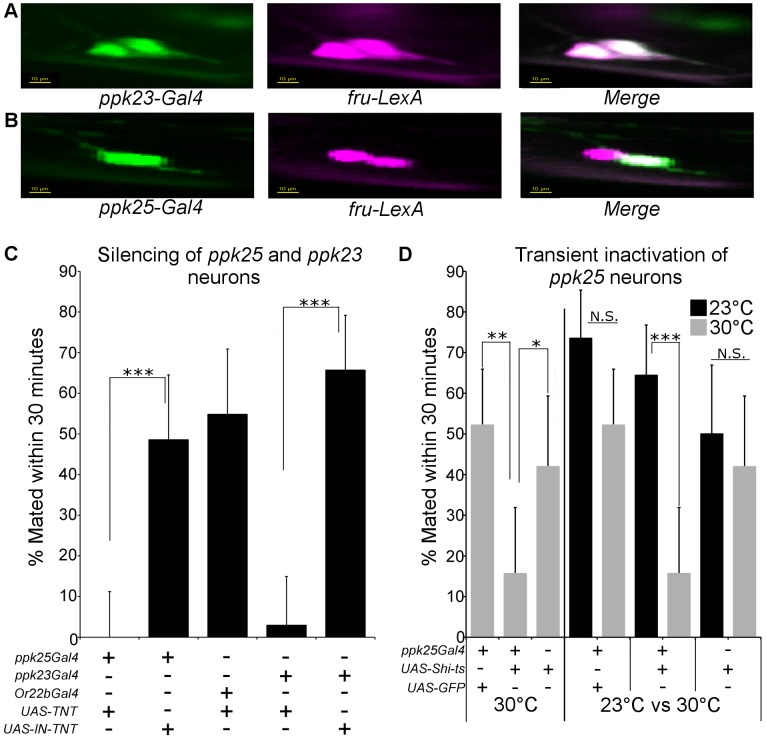
Female ppk25-Gal4 neurons represent a subset of ppk23-Gal4 neurons and are involved in female receptivity.A. Segment of female front legs showing expression of ppk23-Gal4 (green) in each of the two fru-positive cells (fru-LexA, magenta) under each chemosensory bristle. Scale 10 µm. B. Segment of female front legs showing expression of ppk25-Gal4 (green) in only one of the two fru-positive cells (fru-LexA, magenta) present under each chemosensory bristle. Scale 10 µm. C. Silencing of ppk25-Gal4 or ppk23-Gal4 neurons reduces female receptivity. Receptivity was calculated for females expressing active (UAS-TNT) or inactive (UAS-IN-TNT) forms of TNT under control of either ppk23-Gal4 or ppk25-Gal4. Additional control females contained UAS-TNT driven by Or22b-Gal4, which is expressed in a neuronal subset not associated with mating behaviors [36]. N = 30–35; ***p<0.001 (Fisher's exact test). D. Transient inactivation of ppk25-Gal4 neurons inhibits female receptivity. Females expressing the temperature-sensitive dominant Dynamin allele shits
[37] under control of ppk25-Gal4 were incubated at either permissive (23°C) or non-permissive (30°C) temperature for 20 minutes prior to, and during the test. Receptivity for females expressing GFP in ppk25-Gal4 neurons or females with UAS-Shi(ts) alone was measured under identical conditions. N = 30–45; ***p<0.001;**p<0.01;*p<0.05 (Fisher's exact test).